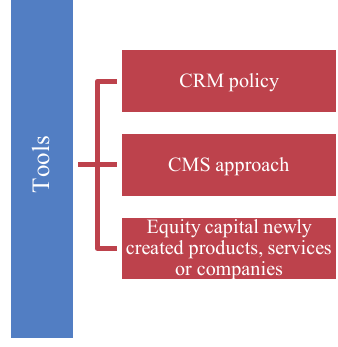
Fig. 1. Innovation commercialization tools in the